Question: Describe this figure in one sentence.
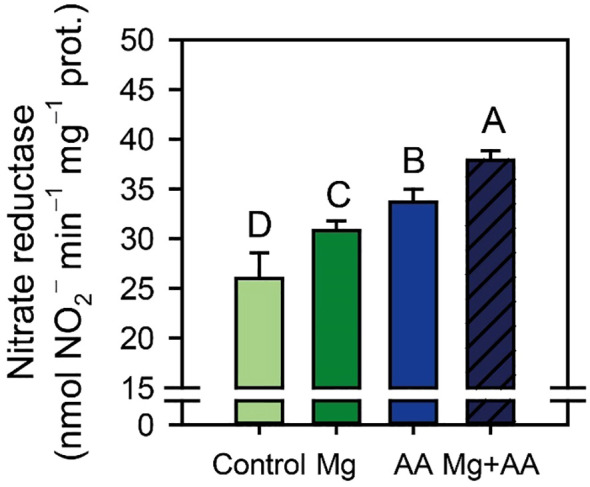
Answer: Nitrate reductase activity in the leaves of maize plants as affected by the foliar application of magnesium (Mg) and/or amino acids (AA). Bars represent means across the 2021 and 2022 off-season growing periods. Different letters indicate significant differences among treatments (LSD, p ≤ 0.05). Error bars represent standard deviation (n = 8).